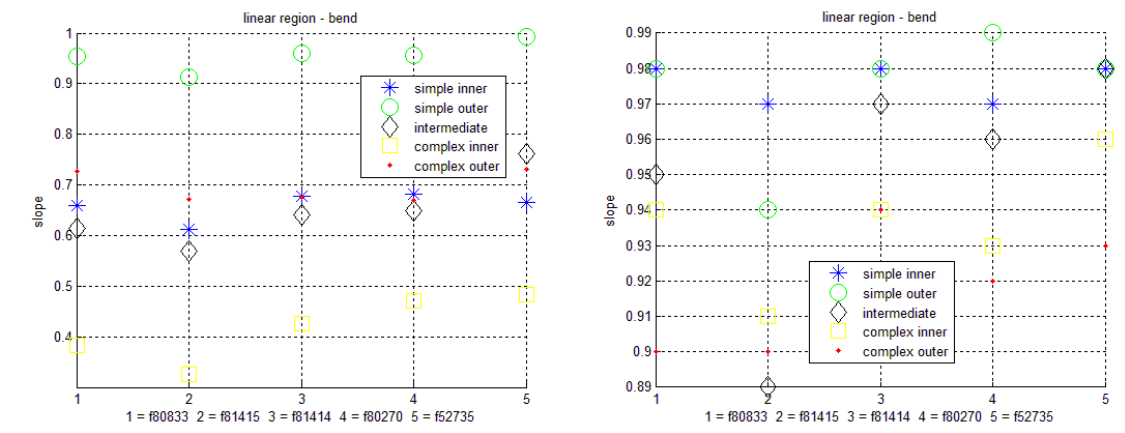
Figure 18. Linearity, bending phase: ( left ) un-insulated case; ( right ) insulated case.